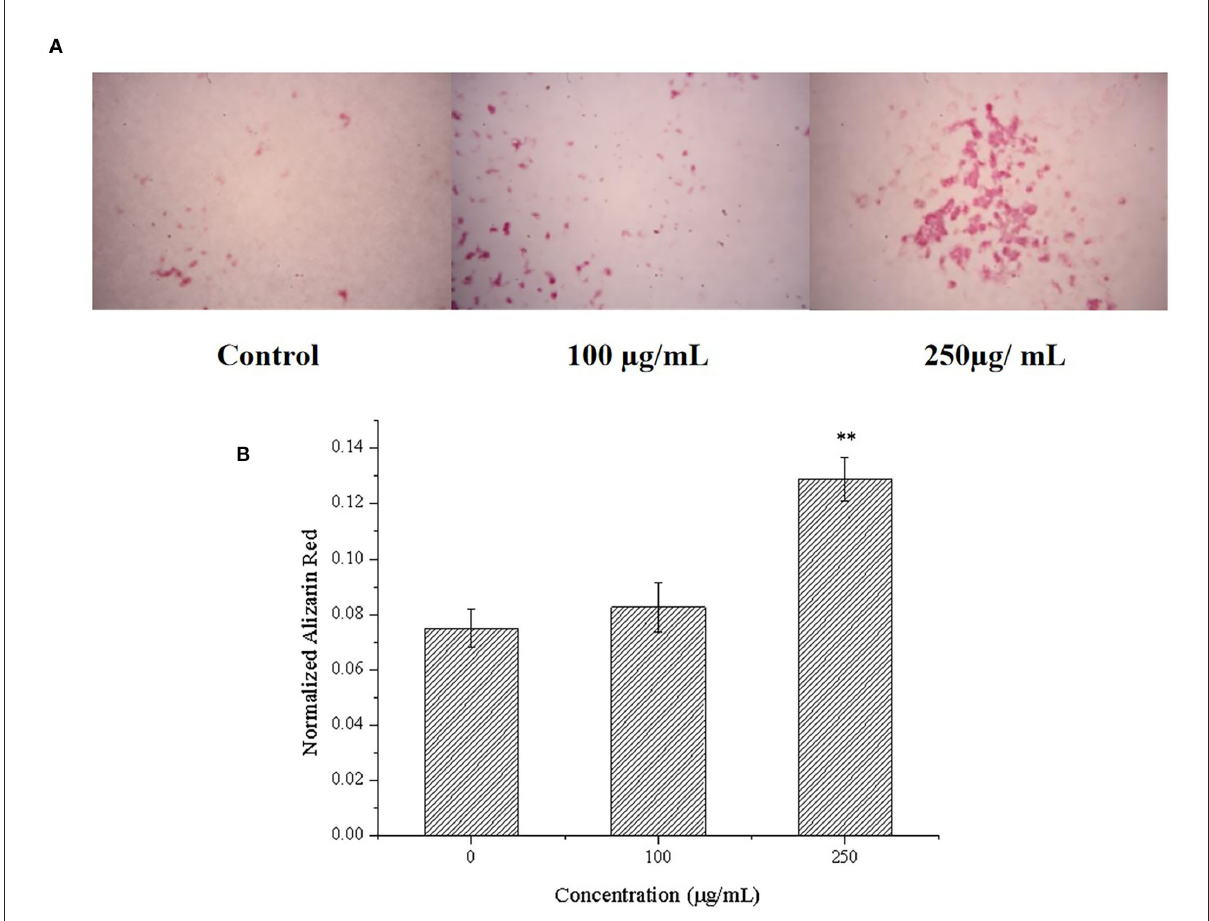
FIGURE6 Effect of CPP-Ca on the mineralization of MC3T3-E1 cells. Alizarin red staining of mineralization nodules (A) and the quantification of the mineralization nodules (B) . * p < 0.05; ** p < 0.01, compared with the control